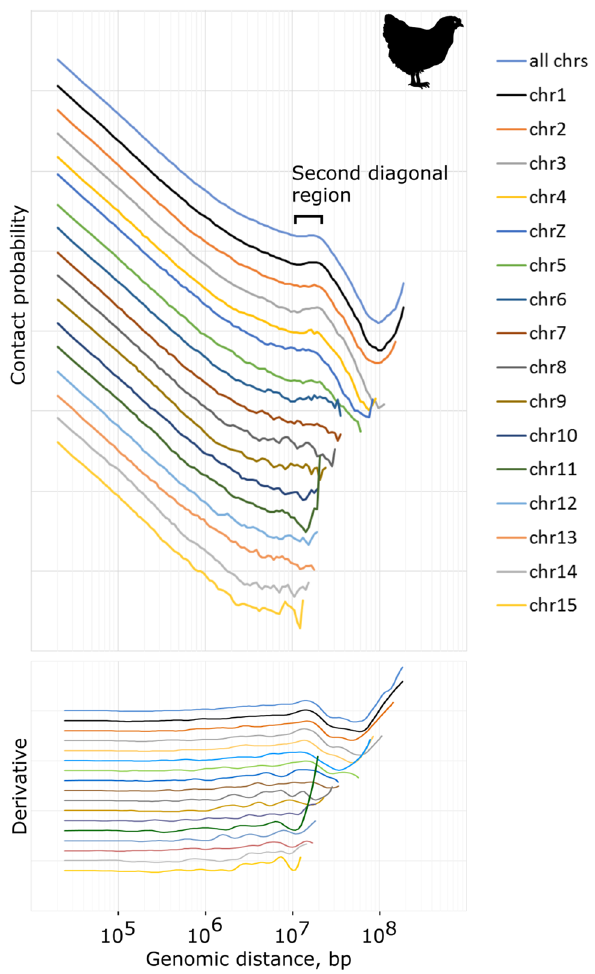
Figure 2. Contact frequency P(s) derived from Hi-C data obtained from chicken erythrocytes. Curves for genome average (all chrs) and long individual chromosomes are shown. The hump of the second diagonal is obvious on the first ~ six longest chromosomes. Bottom panel: derivatives of P(s)